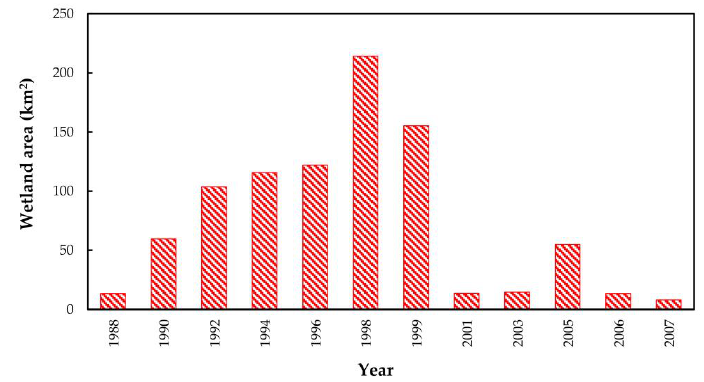
Figure 4. Variation of wetland area in study